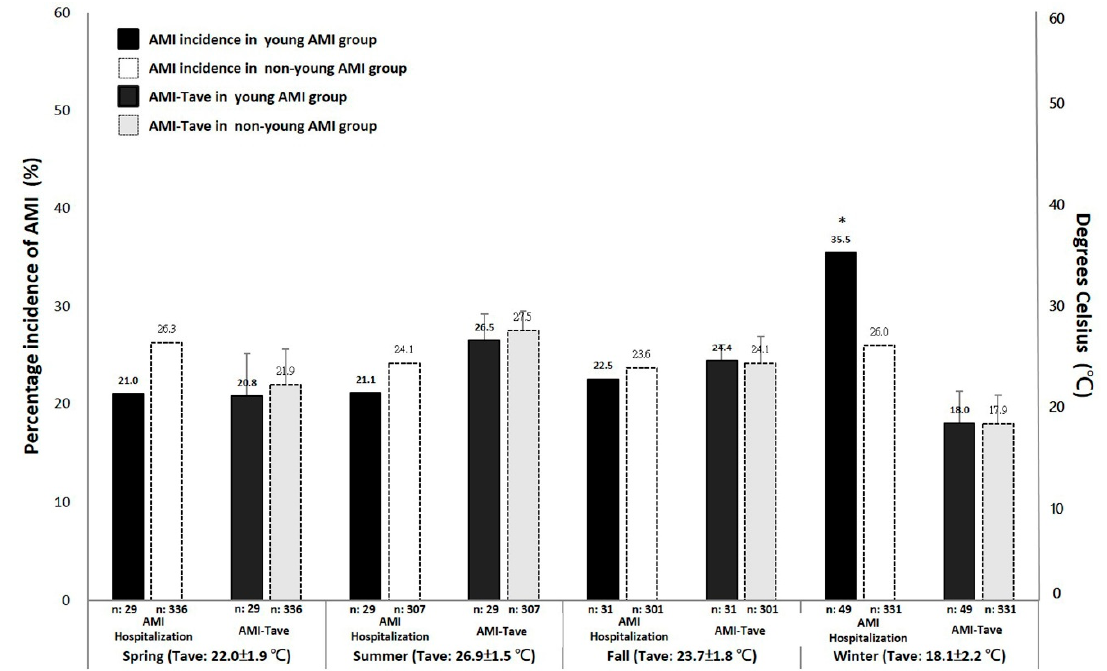
Figure 1. Seasonal distribution of AMI hospitalizations and the average temperature (Tave) on the date of AMI hospitalization (AMI-Tave) in the under-45 group and the over-45 group. * indicates p < 0.05 vs. spring, summer, and fall.